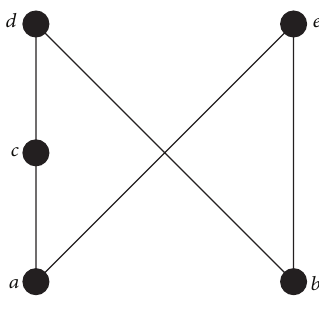
Figure 1: Hasse diagram of 𝑃 4